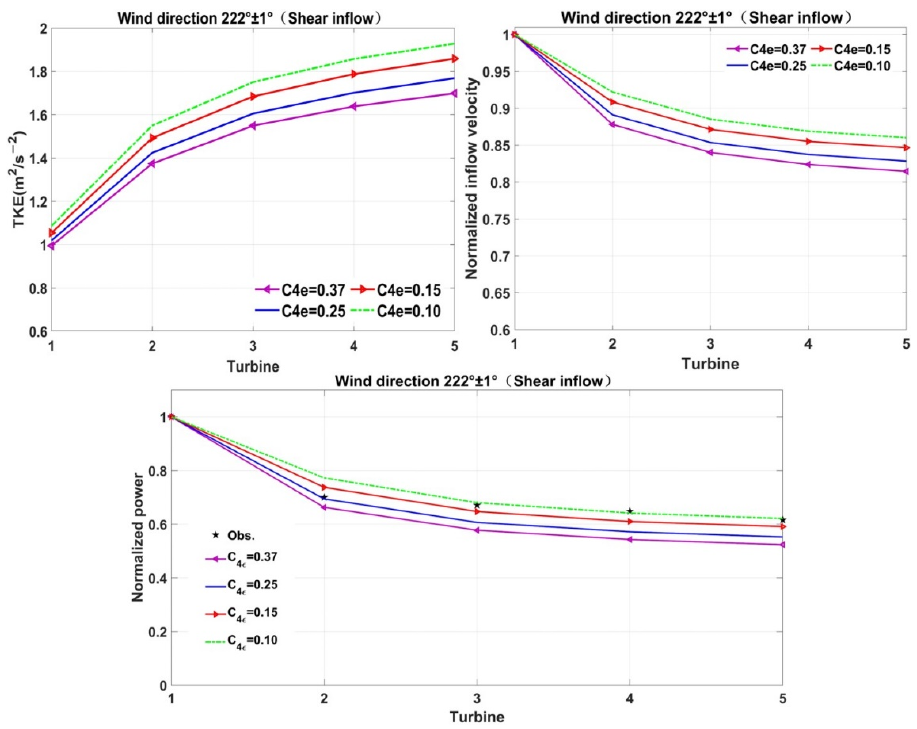
Figure 16. Effects of different C 4 ε values on TKE, inflow wind speed and power output under shear inflow conditions when the incoming wind direction is 222 ± 1°.